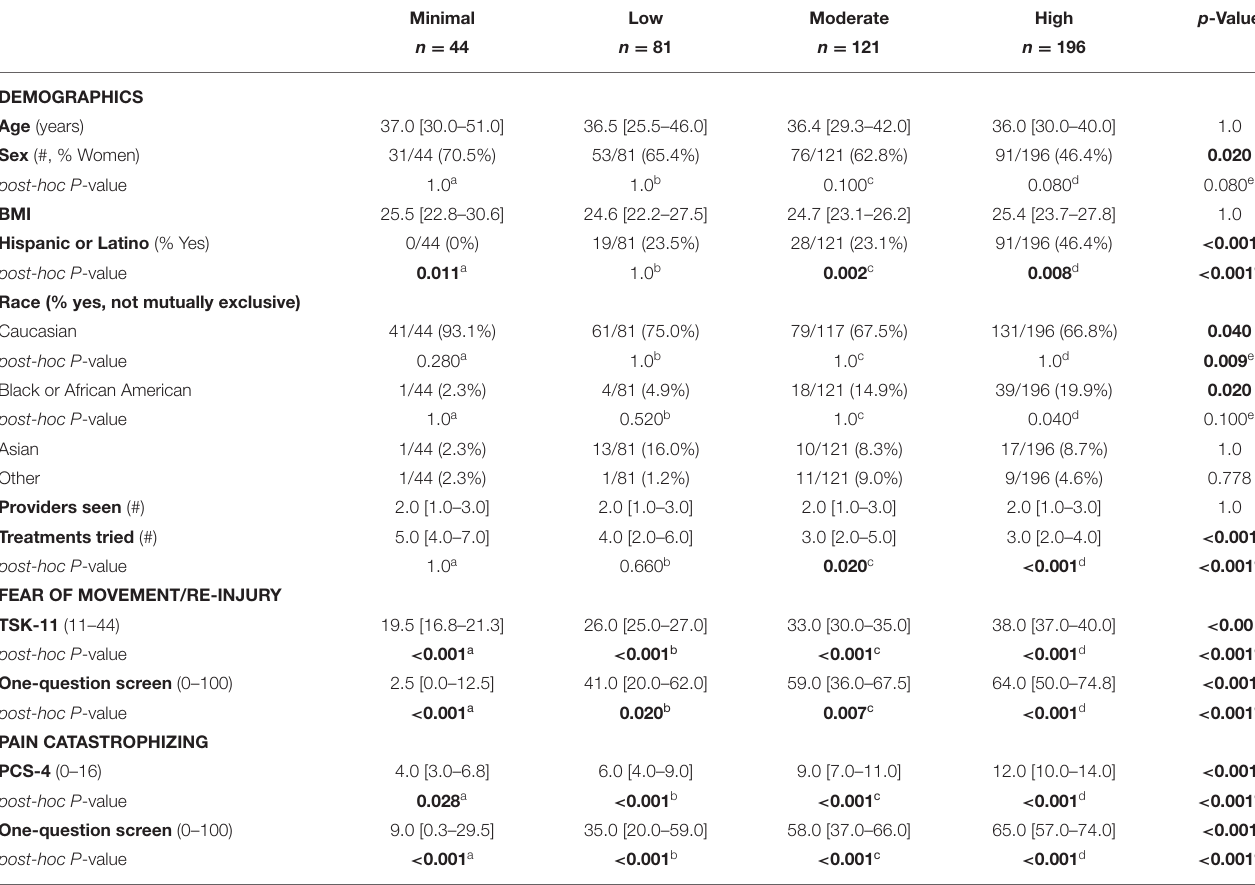
TABLE 1 | Demographics, fear of movement, and pain catastrophizing compared between groups by levels of kinesiophobia on the 11-item Tampa Scale of Kinesiophobia (TSK-11) score as Minimal (TSK ≤ 22), Low (TSK 23–28), Moderate (TSK 29–35), and High (TSK ≥ 36). Minimal Low Moderate High p